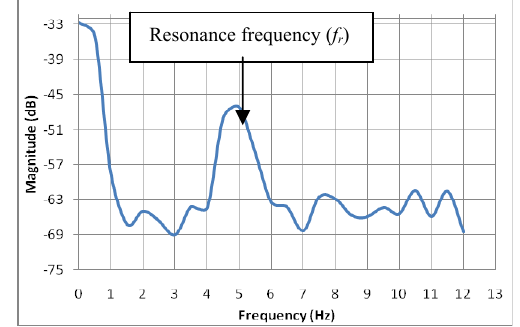
Figure 3. Response of frequency with attached mass of the CFFF specimen [±20] 2s